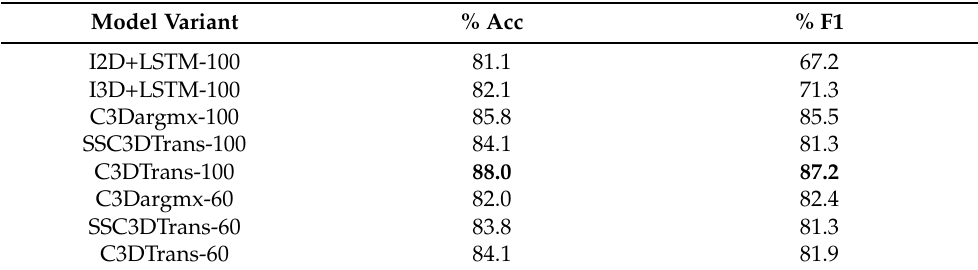
Table 4. Clip-level results of the peg transfer (PT) task. The best results column-wise are shown in bold.